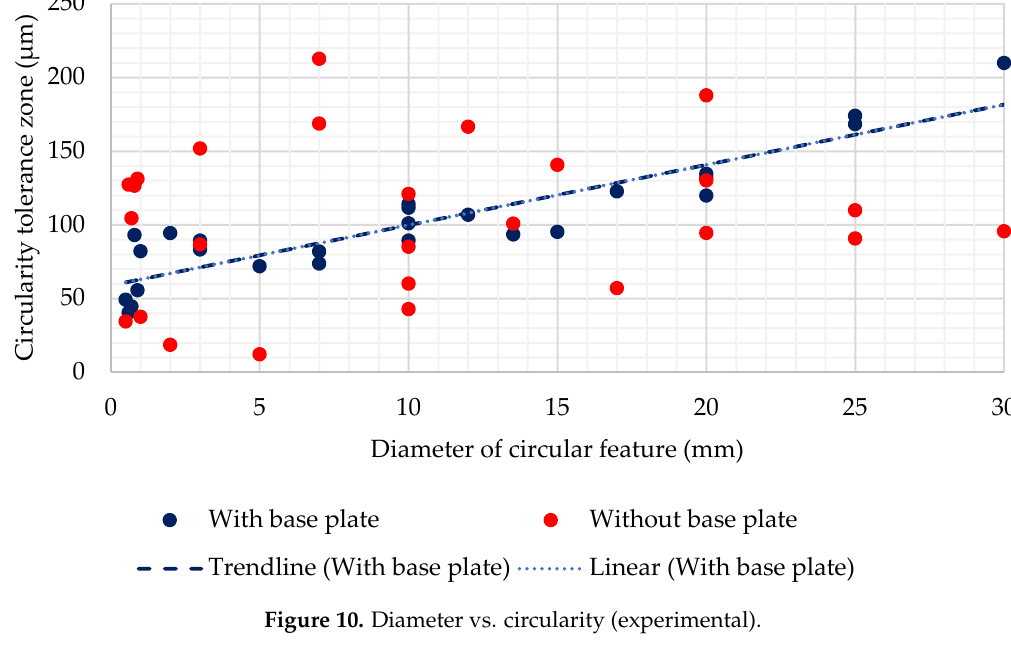
Figure 10. Diameter vs. circularity (experimental).